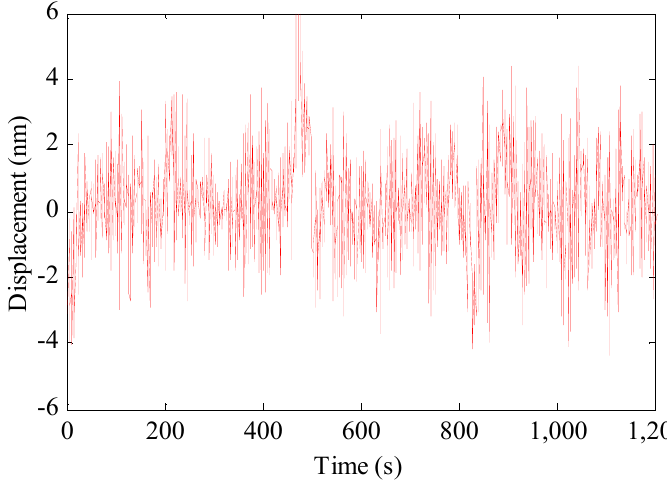
Figure 5. Resolution of the laser interferometry sensor.